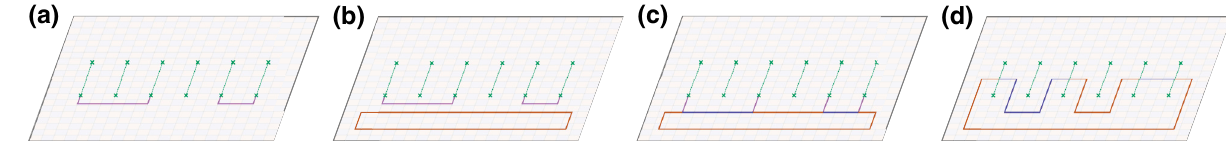
FIG. 28. All Pauli logical operators for twist-encoded qubits are traceable. (a) An arbitrary Pauli operator can be expressed as a product of composite primal-dual (Pauli- Y ) strings connecting pairs of twists, as represented by the purple strings. (b) Multiply this logical by a trivial primal or dual loop (i.e., a stabilizer). (c) The results in a new string net configuration, involving primal, dual, and composite primal-dual strings in general. (d) This string net can be further resolved to a new traceable string net consisting of only primal and dual strings enclosing some number of twists.